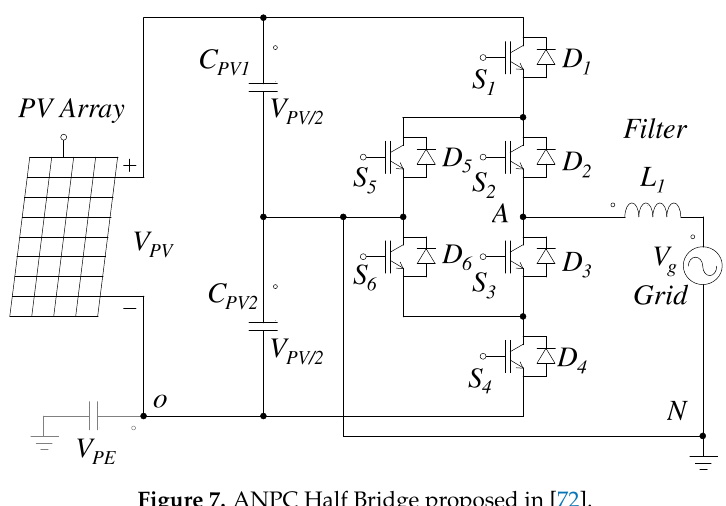
Figure 7. ANPC Half Bridge proposed in [72]. Table 6. Switches states of adjustable losses distribution of ANPC Half-Bridge inverter proposed in